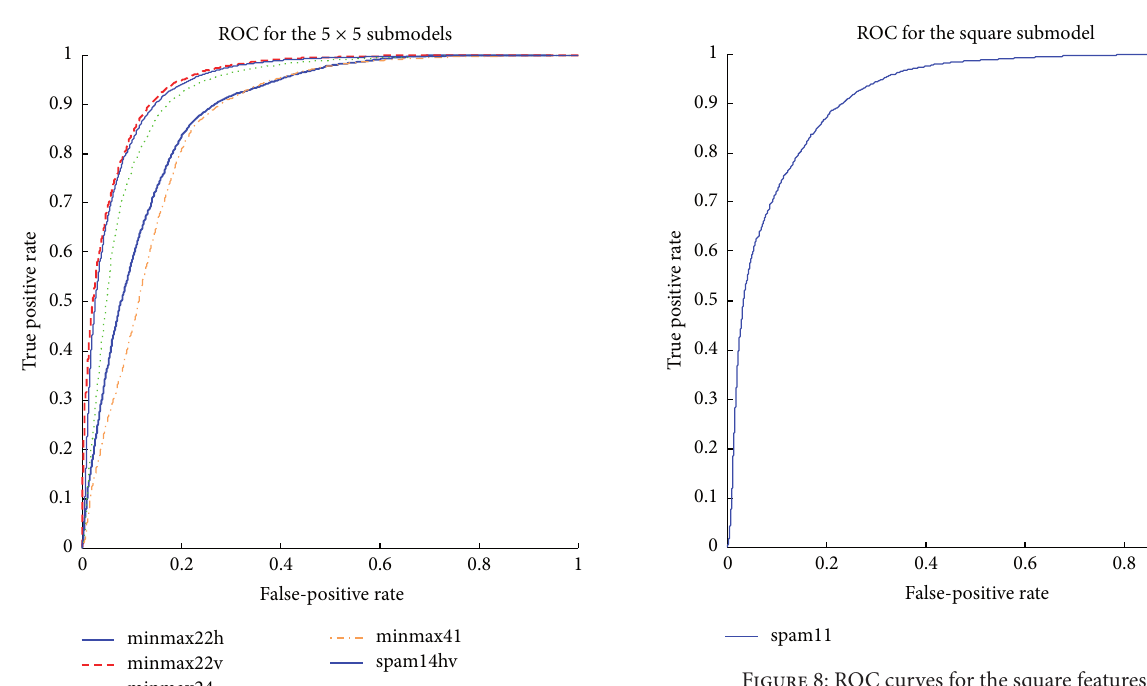
Figure 8: ROC curves for the square features.